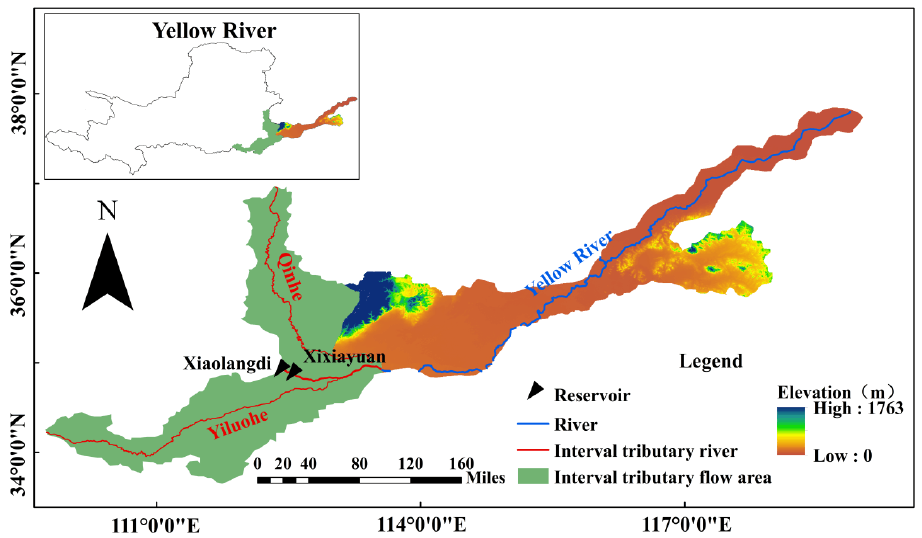
Figure 1. Location overview of Xiaolangdi.